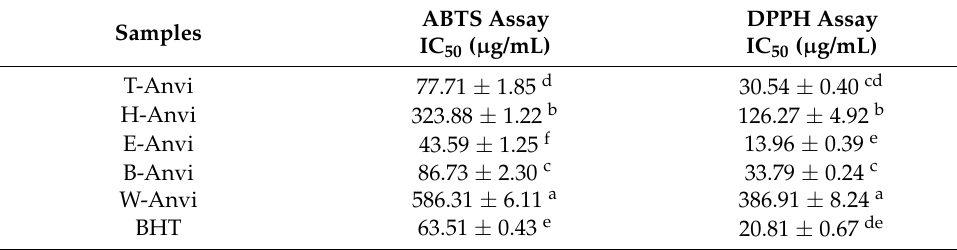
Table 2. Anti-radical activities of A. virginicus extracts.